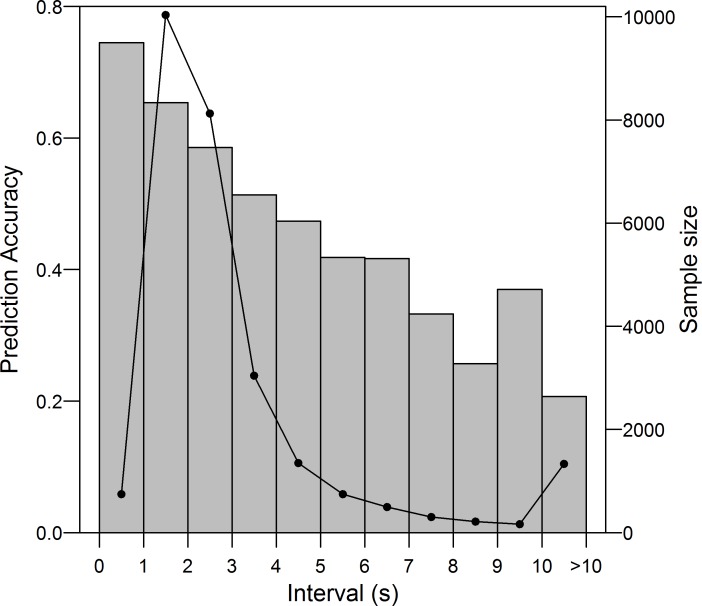
The relationship between the predictability of upcoming phrases and singing rate of Cassin’s Vireos (gray bars).Predictions were derived from the ‘interpolated’ Markov model using the train-test paradigm. Sample sizes for each interval are shown (black circles).